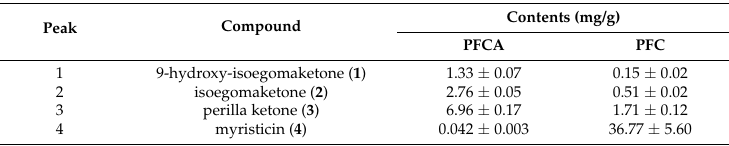
Table 2. The contents of compounds in the leaves of PFCA and